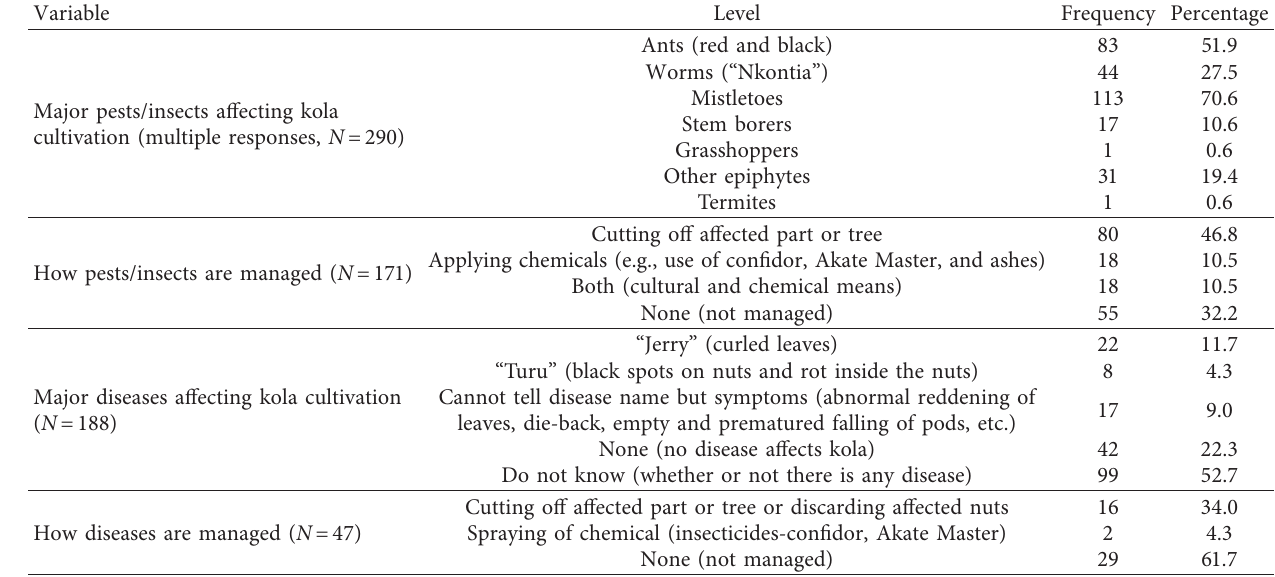
Figure 6: Map showing kola production trend in clusters of 10 km radius in the surveyed areas. Table 6: Pests/insects and diseases of kola